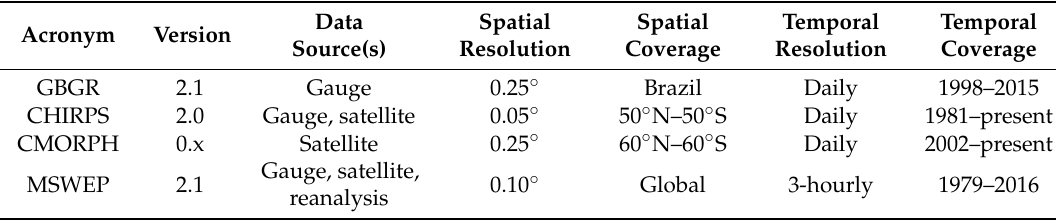
Table 2. Main features of the datasets